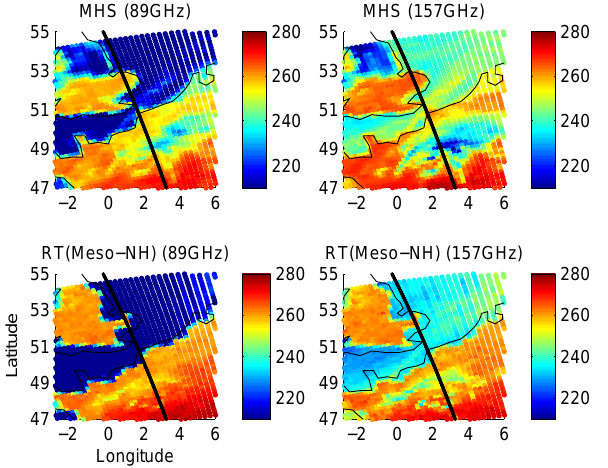
Figure 2. MHS observations at 89 and 157GHz (top panel), as compared with the corresponding simulated brightness tempera- tures with the microphysical scheme intrinsic to Meso-NH (bottom panel). The solid black line illustrates the CloudSat track.